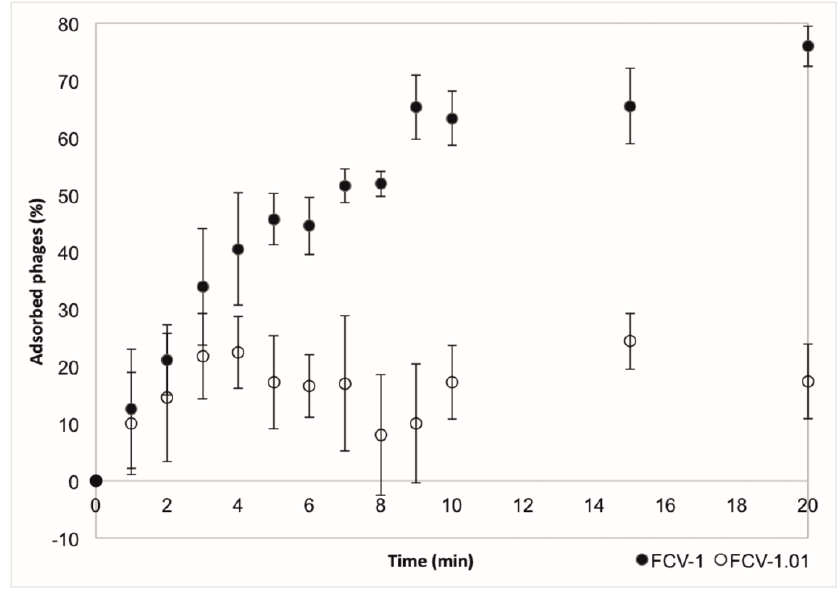
Figure 4. The mean and stdev of a typical adsorption as percentage (%) of adsorbed phage in time (minutes) of the original FCV-1 compared to the evolved FCV-1.01. Experiment was performed in triplicates.